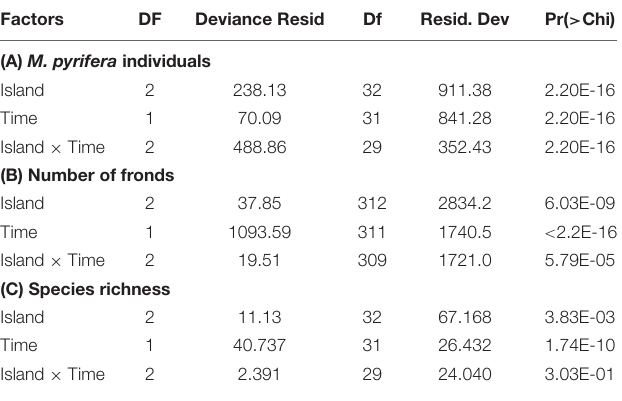
TABLE 1 | Results from the analysis of deviance variance for Poisson generalized linear models (A) for the number of M. pyrifera individuals per 60-m 2 transect, (B) for the number of fronds per M. pyrifera individuals, and (C) for species richness of the fish and invertebrate assemblage. Factors Df